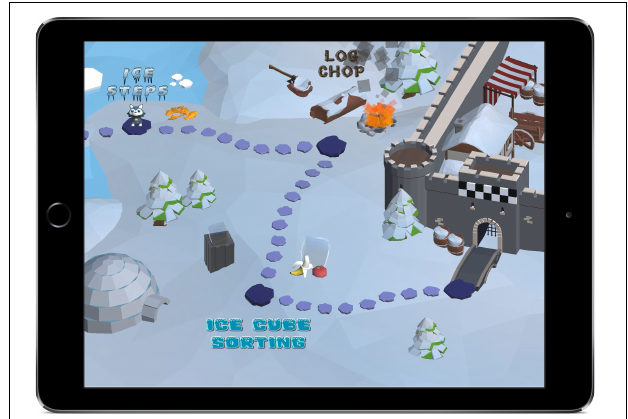
FIGURE 1 | The eFun map screen showing the progressing through the three games. The Ice Steps game which assesses working memory, the Log Chop game which assesses inhibition, and the Ice Cube Sorting game which assesses cognitive